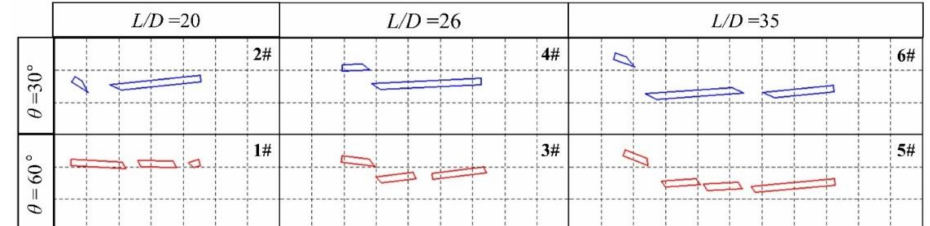
Figure 12. Location pattern of the residual fractured rods after the interaction of long rods having di ff erent L / D ratios with di ff erent interception angles of LEFP (26